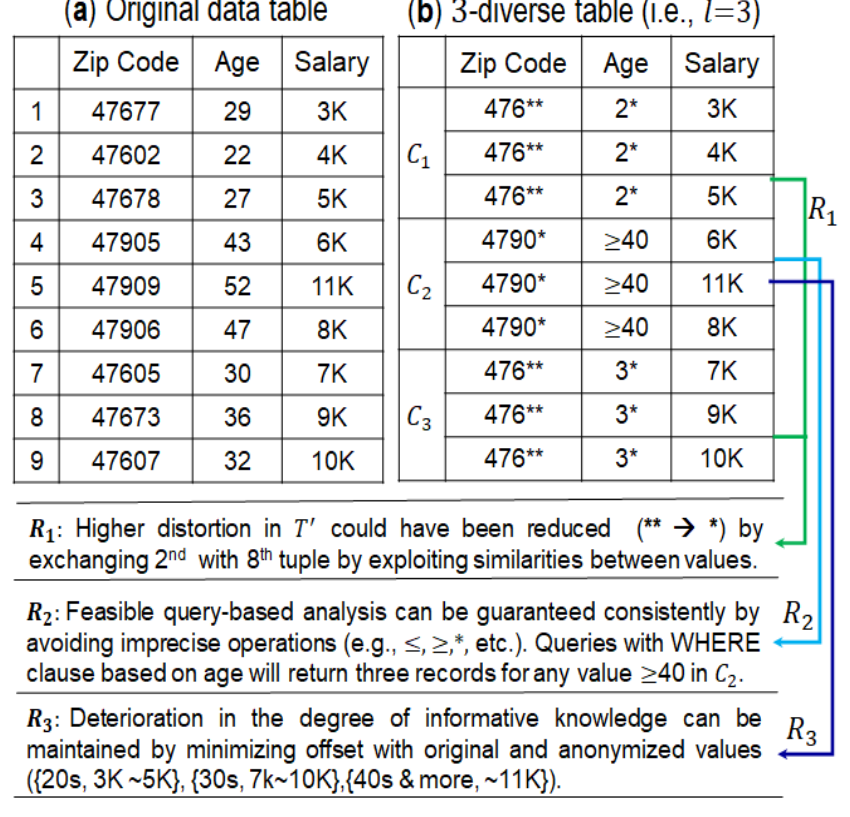
Figure 7. Overview of possible refinements in (cid:96) -diversity anonymity